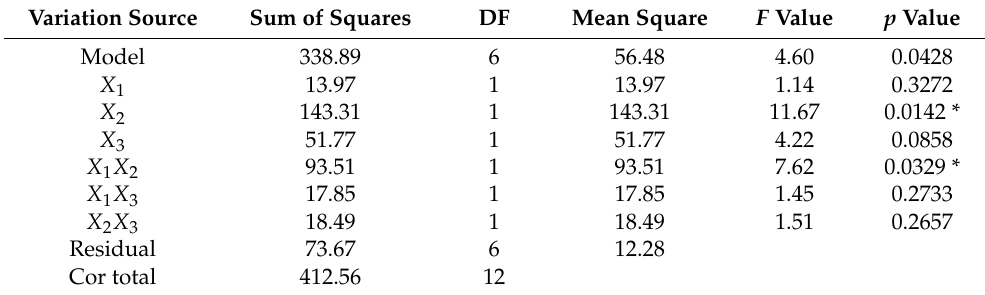
Table 4. Variance analysis results of seedbed preparation machine parameter optimization test for soil breaking rate.